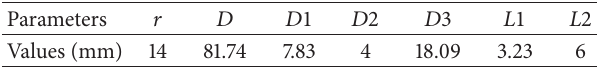
Table 7: Dimensions of the 3D spherical antenna (Figure 18).